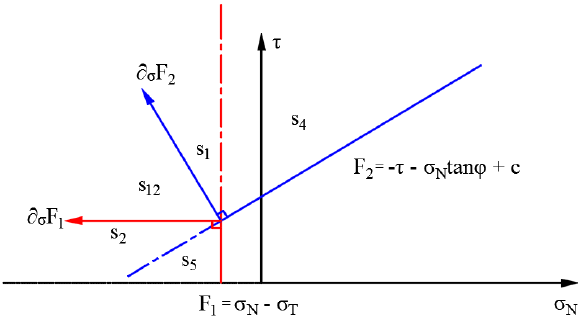
Figure 4. Determination of active surfaces and definition the multi-surface regions.